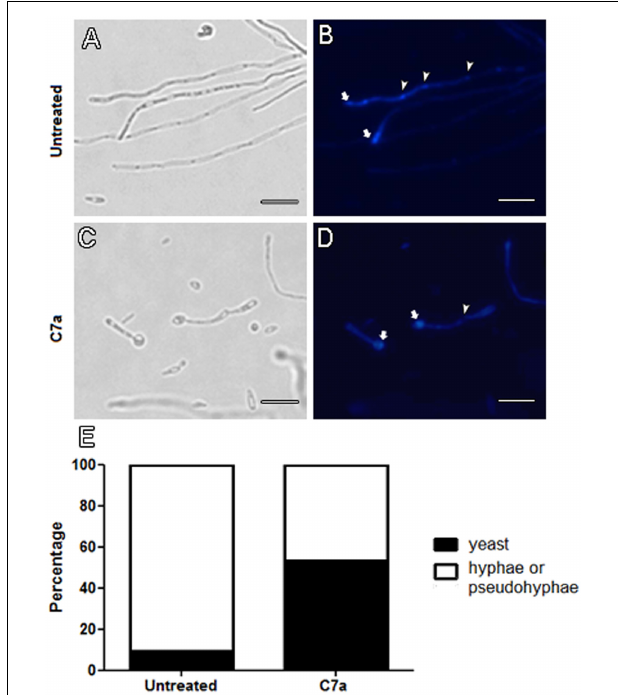
FIGURE 1 | Hyphae/pseudohyphae formation is impaired in C7a-treated cells. Yeast cells of Candida albicans ATCC 10231 were treated with 0.5 µ g/mL of C7a for 24 h at 37 ◦ C in RPMI 1640 buffered with MOPS 0.16 M. Thereafter, untreated cells (A,B) and cells treated with C7a (C,D) were stained with Calcofluor White. Arrows in (B,D) show Calcofluor White staining at the end of hyphae and yeast-mother cell, respectively. Arrowheads in (B) show chitin-rich septa stained by Calcofluor White and in (D) absence of this structure. Yeasts and hyphae/psedohyphae were quantified as described in section “Material and Methods” (E) . Bars = 20